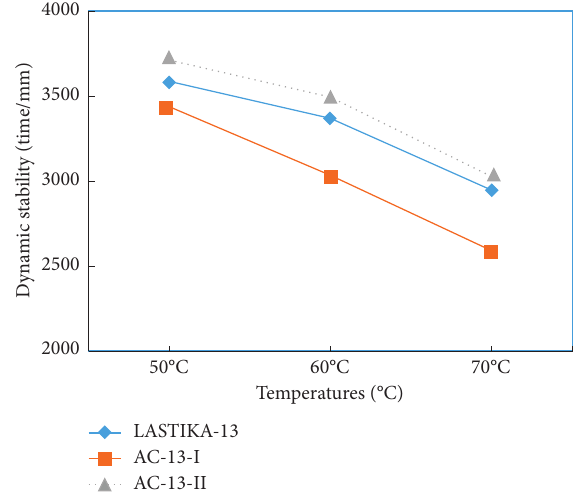
Figure 5: Dynamic stability of asphalt